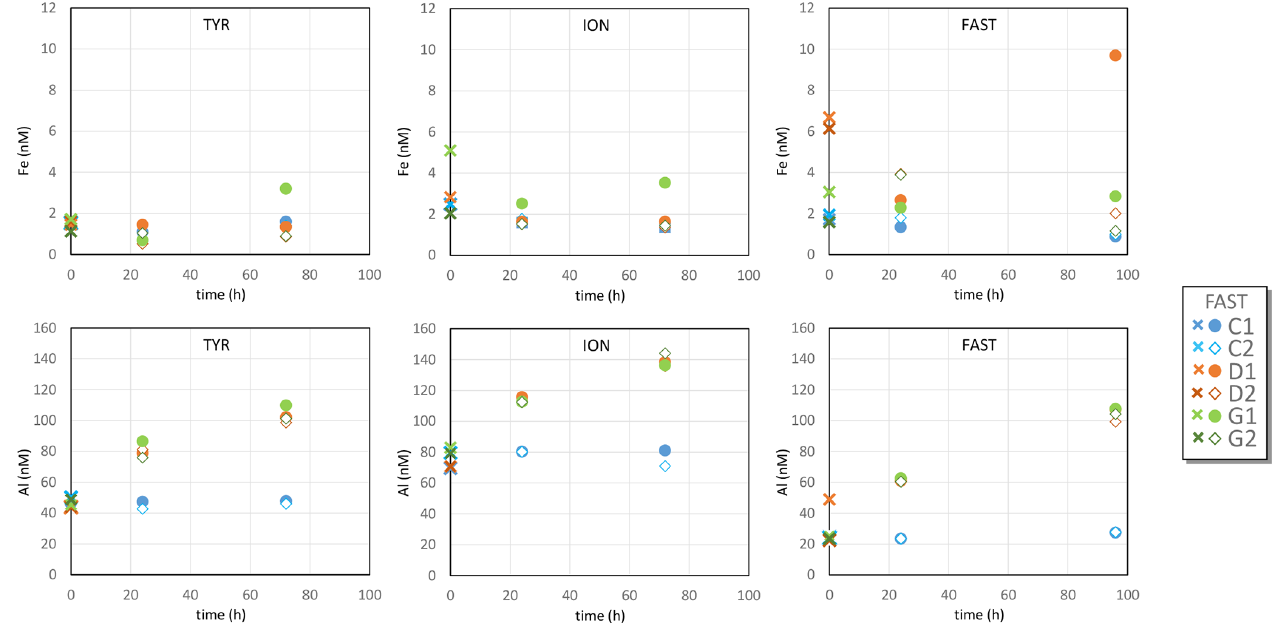
Figure 1. Concentrations of total dissolved Fe and Al during the dust addition experiments. Crosses correspond to samples collected before dust addition ( t =